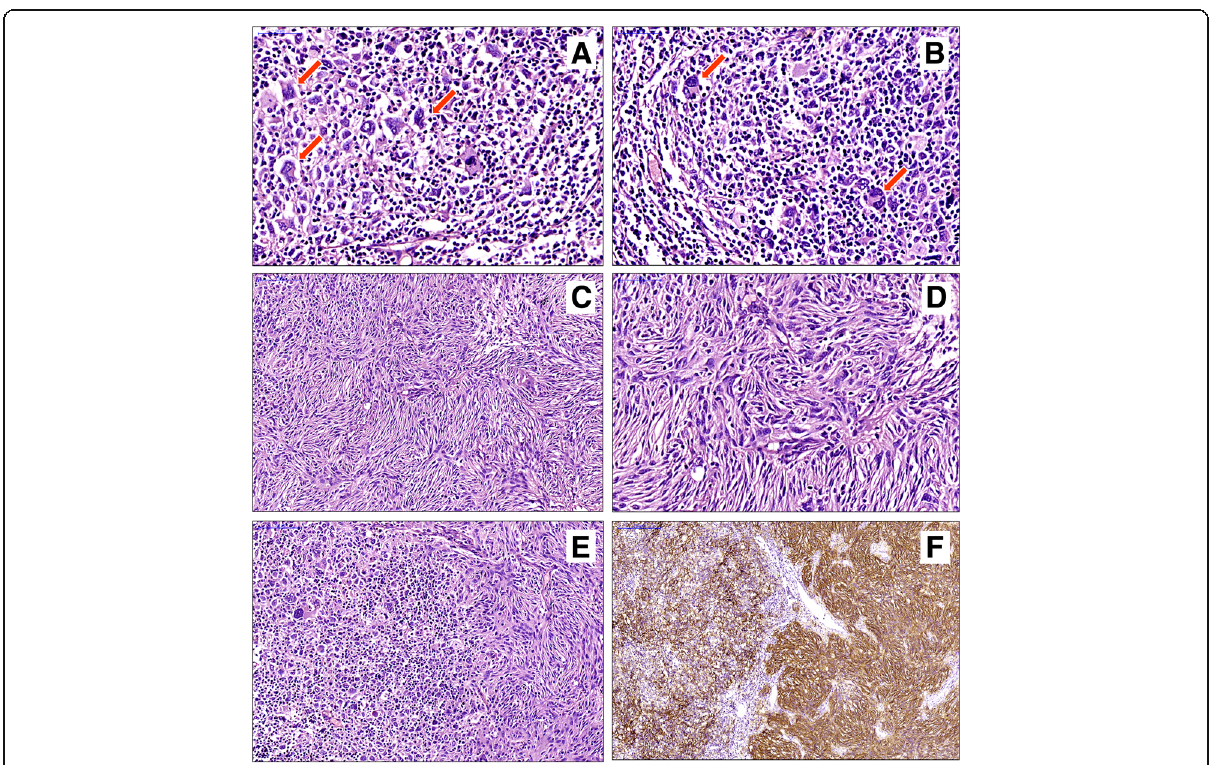
Fig. 5 Mononuclear or binuclear Reed-Sternberg (R-S) cell-like large cells (arrows) are scattered in a background composed of lymphocytes and histiocytes, which resembles classical Hodgkin ’ s lymphoma a , b . Low- and high-power views show the typical histology of FDCS, which consists of ovoid- to spindle-shaped cells in a storiform pattern ( c , d ). In some regions, the transition between the areas, such as those of classical Hodgkin ’ s lymphoma and those with the typical morphology of FDCS, can be found ( e ), both of which are positive for CD21 ( f